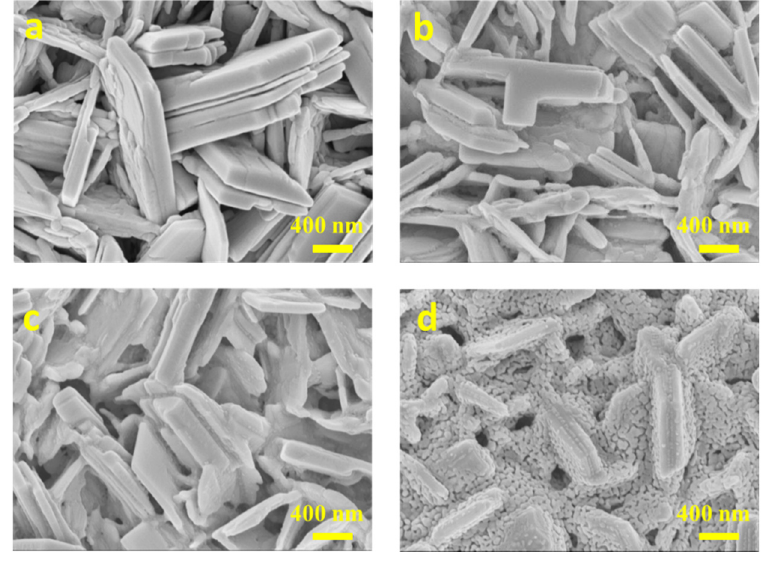
Figure 2. SEM images of ( a ) WO 3 , ( b ) WB-3cycle, ( c ) WB-7cycle and ( d )